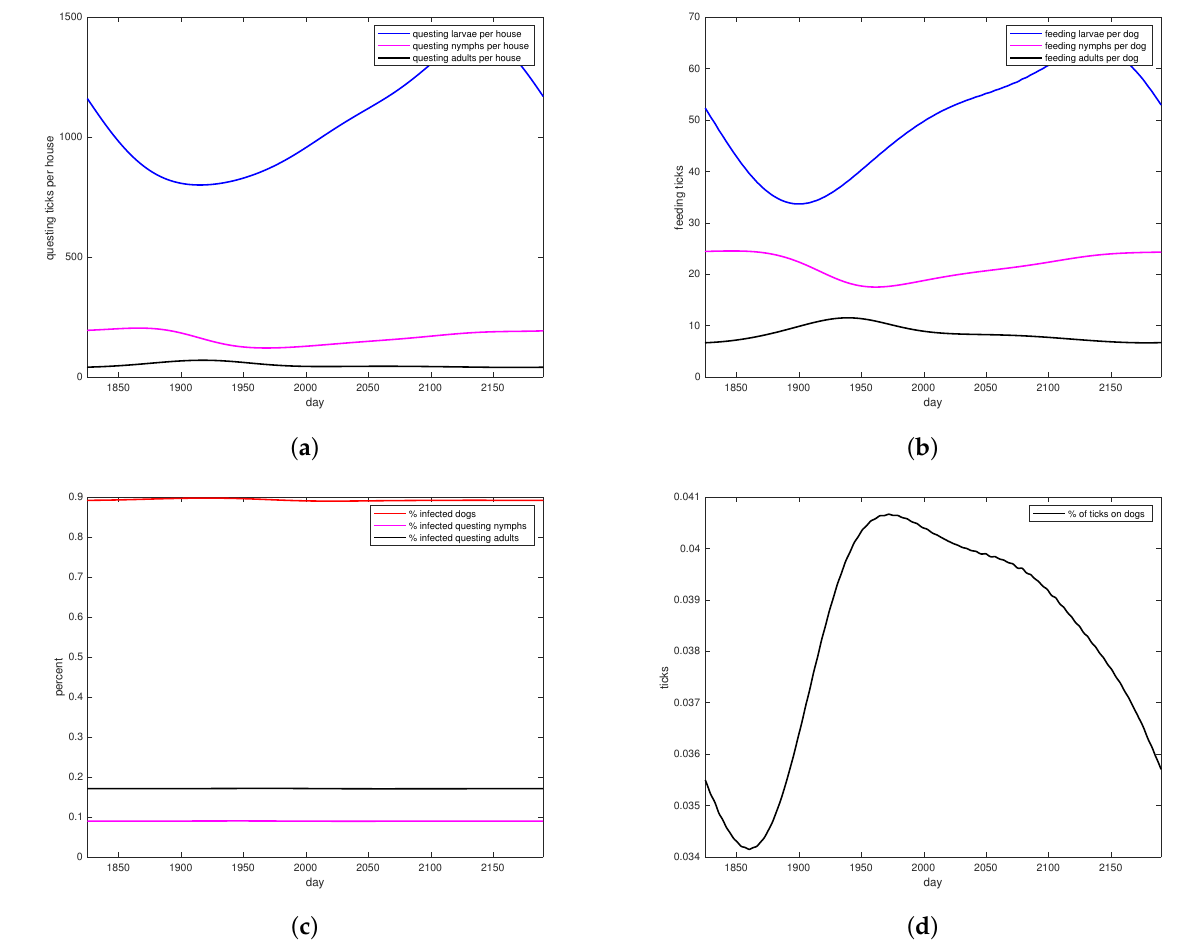
Figure 3. Simulations of tick abundance and RMSF prevalence for no treatment. ( a ) Questing larvae, nymphs and adults per house, at year 6 steady state. ( b ) Feeding larvae, nymphs and adults per dog, at year 6 steady state. ( c ) RMSF prevalence patterns with no treatment. Percent infectious nymphs, adults, and dog hosts are shown. ( d ) Ratio of feeding ticks to all ticks in all stages, shown at year 6 steady